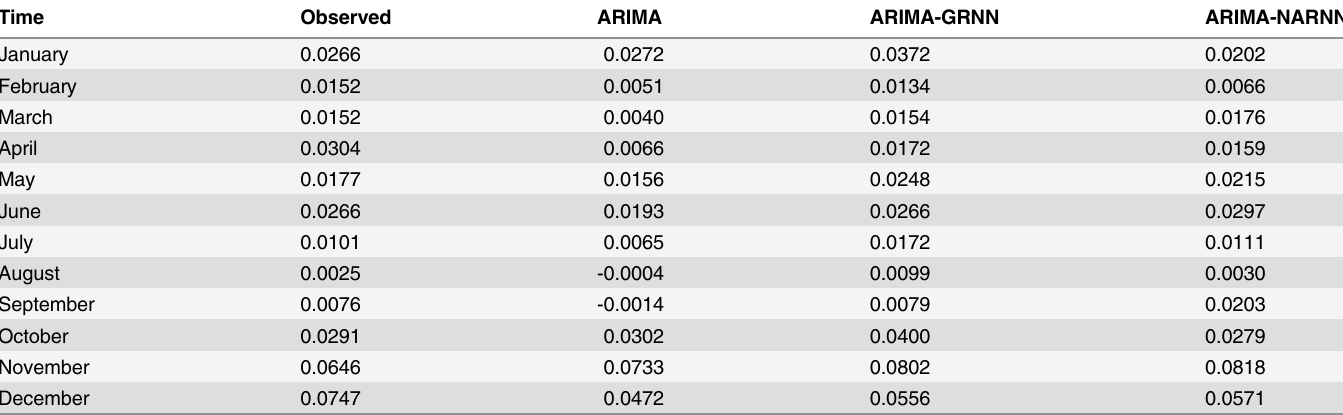
Table 3. Incidence values for 2012 forecasted by ARIMA, ARIMA-GRNN and ARIMA-NARNN model.